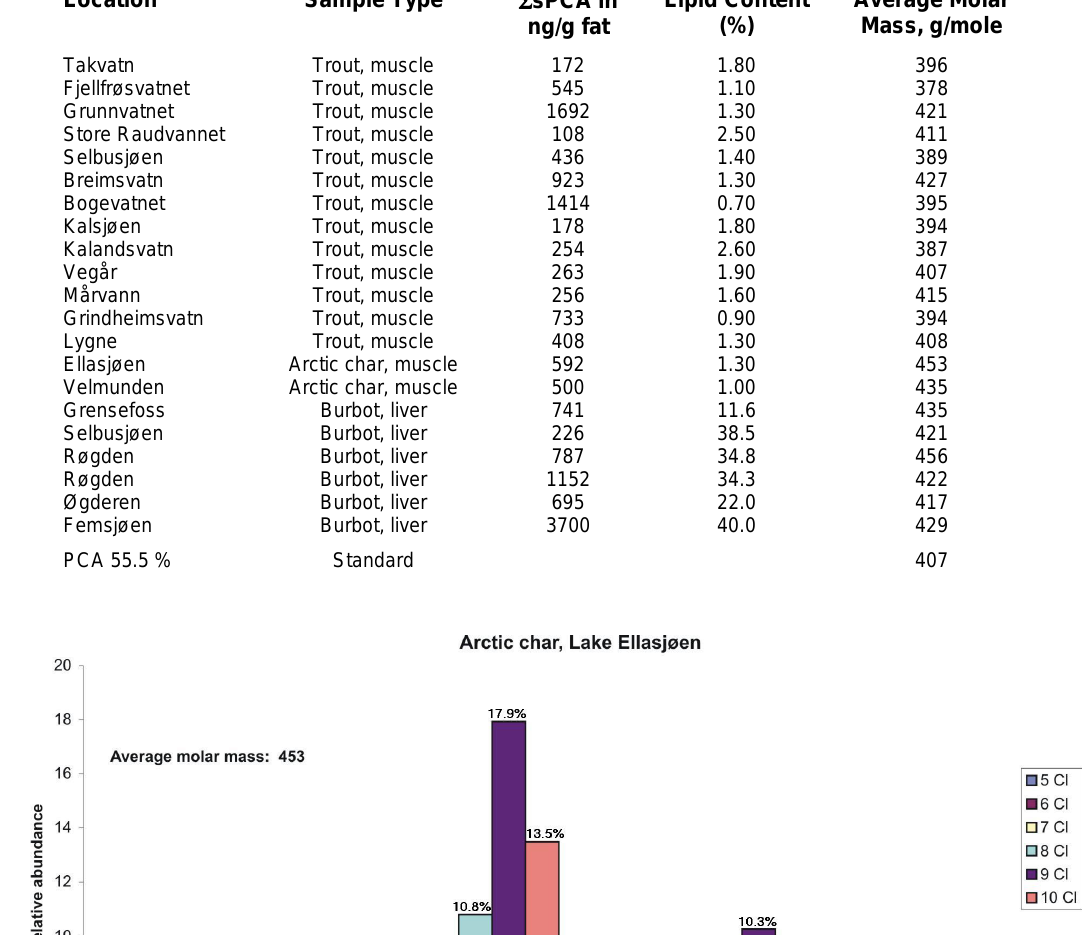
Concentrations and Calculated Average Molar Masses of Short-Chained and Highly Chlorinated PCA in Freshwater Fish Samples from Different Locations in Norway Location